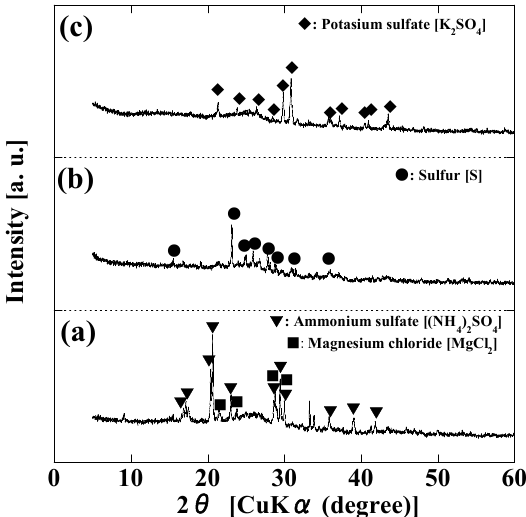
Figure 2. XRD patterns of (a ) raw ash, (b ) Ash-K 2 S, and ( c ) Ash-KOH.